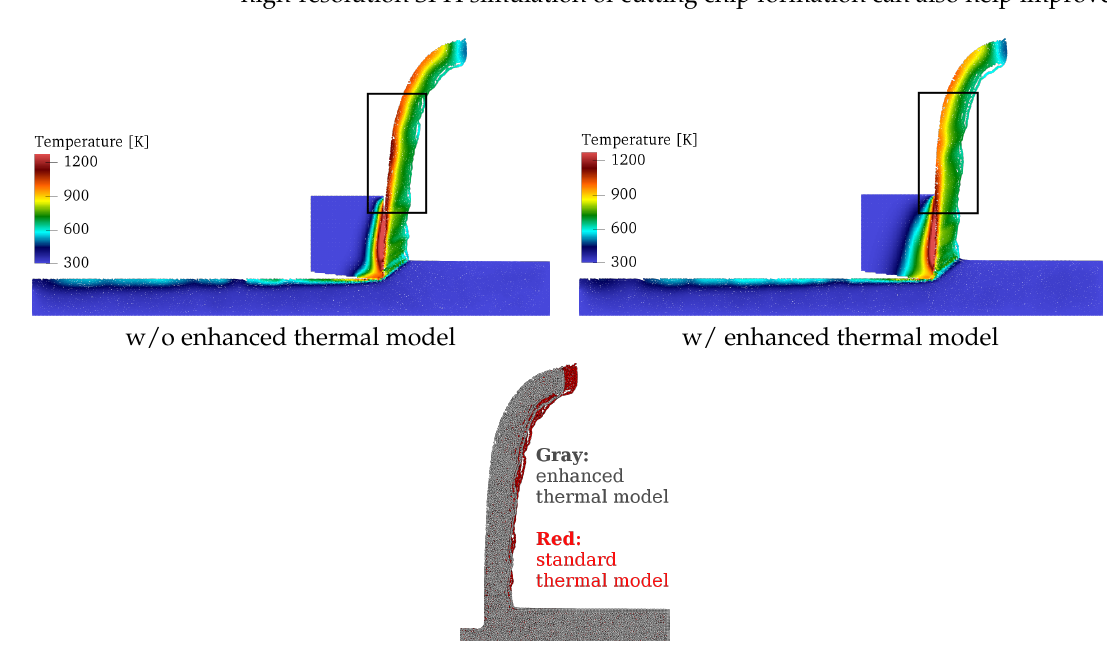
Figure 7. Distribution of the temperature after 2 mm of cut. Lower temperatures are observed in the enhanced model by comparing the two black frames. Simulated chip shapes are superimposed to give insights into the impact of the heat loss boundary condition on chip